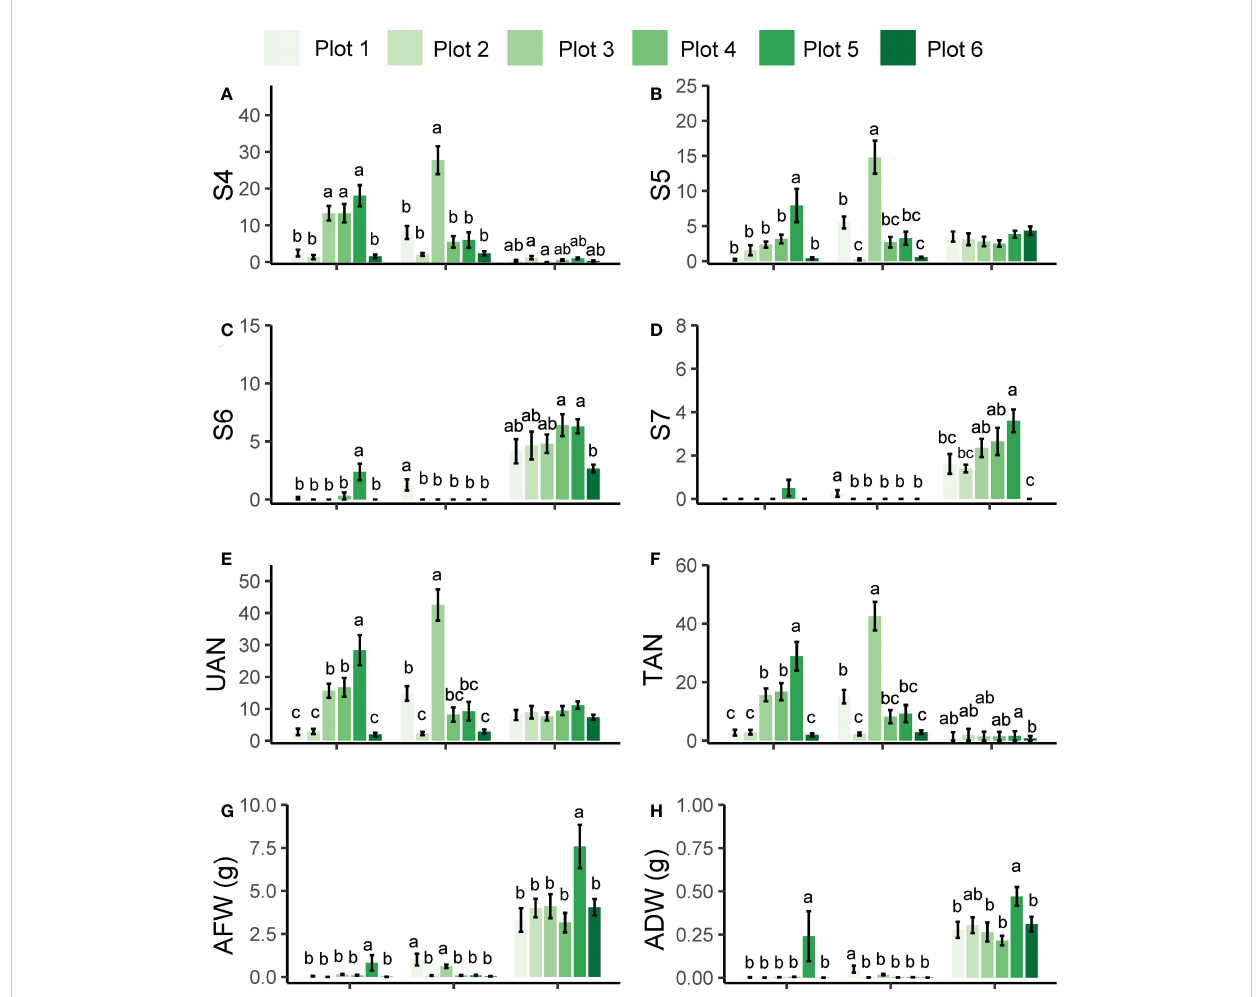
FIGURE 4 Development and biomass of six P. aegyptiaca populations attached to the roots of KR1326, Huangpi9818, and K1076 at 60 DAI. (A – D) The number of P. aegyptiaca at S4, S5, S6, S7 stages per host plant. (E) Total number of underground attachments per host plant (UAN). (F) Total number of P. aegyptiaca attachments per plant (TAN). (G) Fresh weight of total attachments per host plant. (H) Dry weight of total attachments per host plant. Vertical bars represent the mean ± SE, while letters represent mean separations at P ≤ 0.05 by Tukey ’ s HSD test ( n = 10 biological